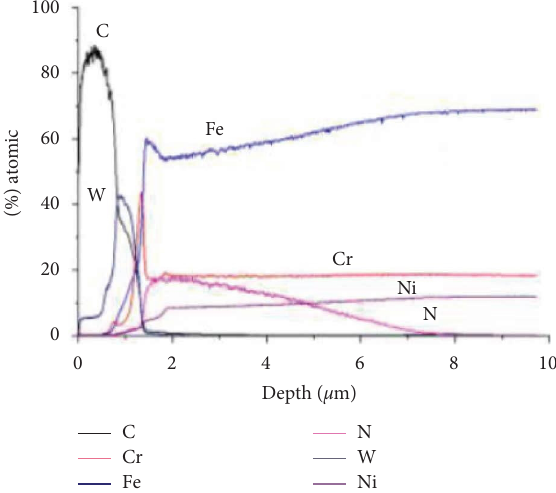
Figure 2: Glow discharge optical emission spectrometry (GDOES) concentration profle of ASPN 350 ° C+ DLC WC:C